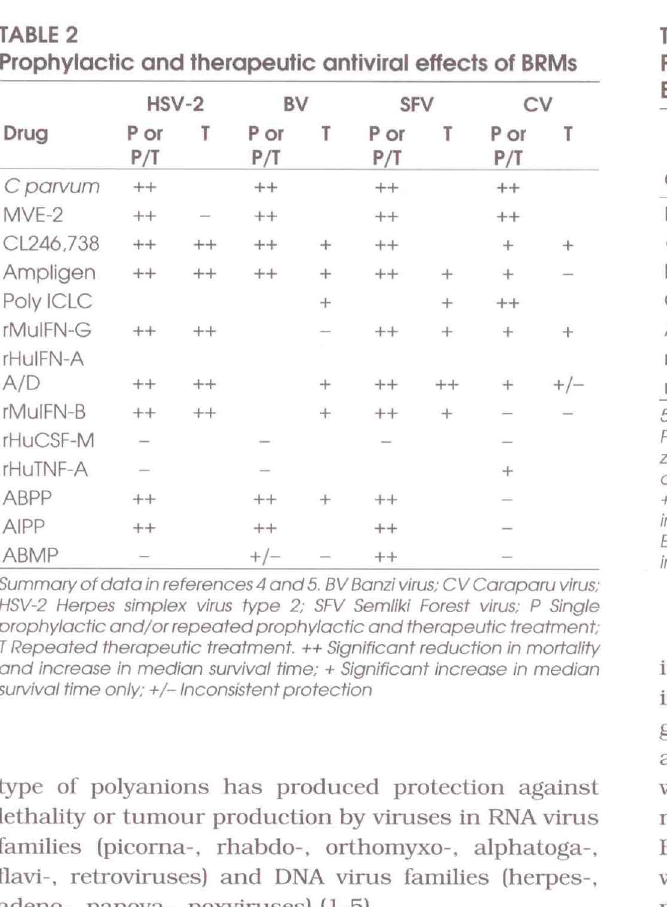
BRM administration that provide antiviral efficacy Peritoneal macrophage